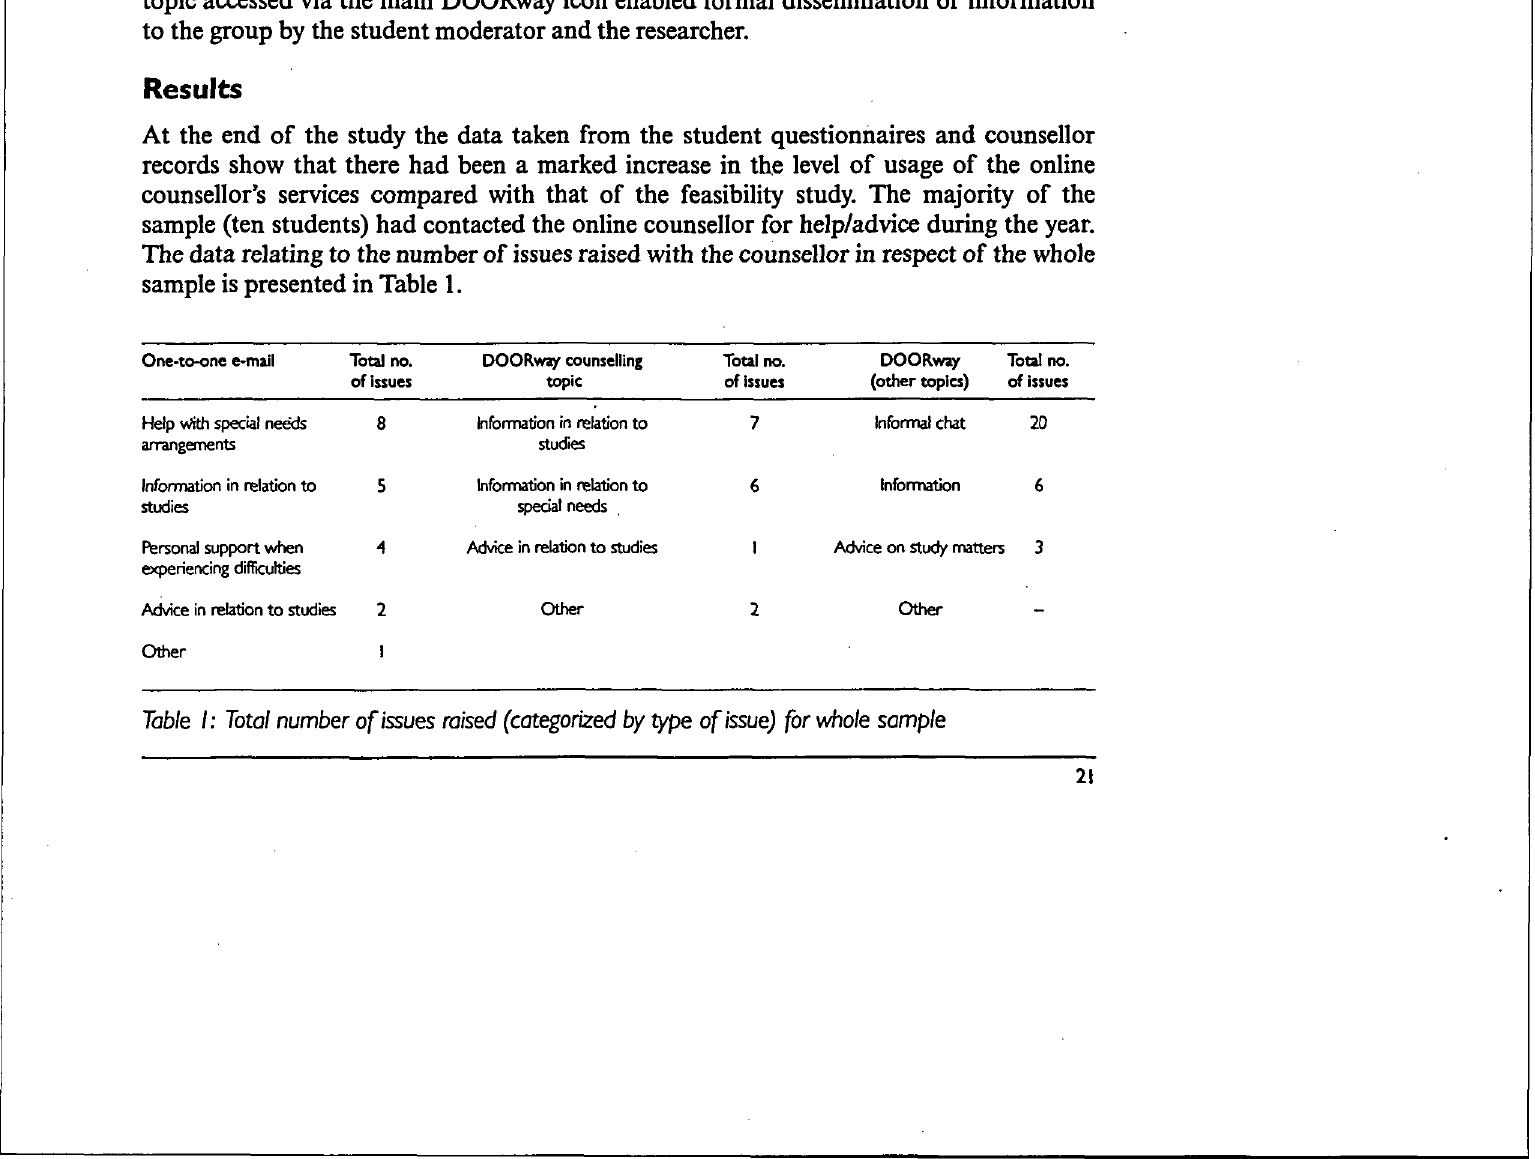
Figure /."The DOORway Desktop - introducing an interactive group dimension to personal educational counselling online